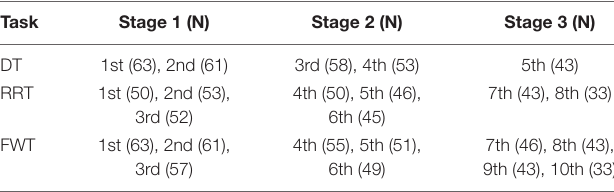
TABLE 3 | Three stages of the assignments completed by the training group. Task Stage 1